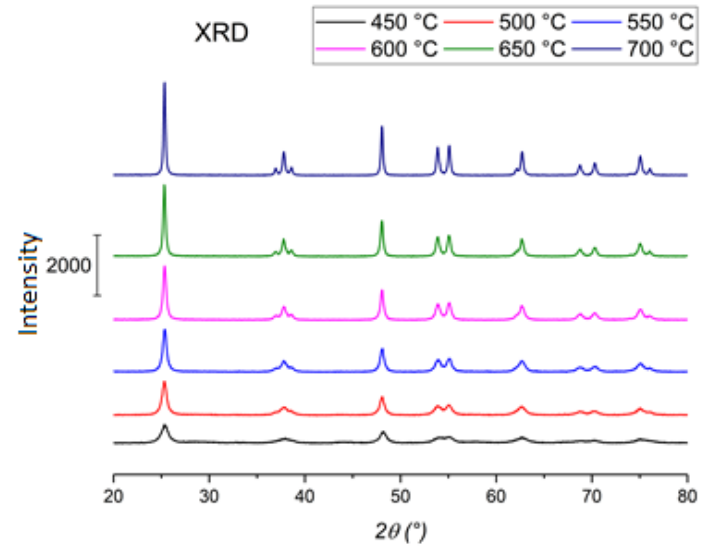
Figure 4. X-ray diffraction (XRD) patterns of samples treated at different temperatures.